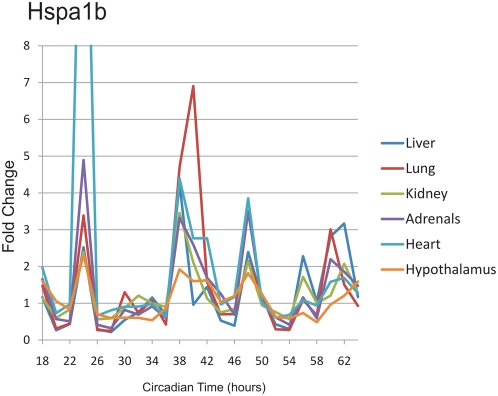
qPCR profiling of Hspa1b reveals 12 h rhythms in multiple tissues.RNA samples from six different tissues were collected at a two-hour resolution between CT18 and CT64. These samples were analyzed using qPCR probes, median normalized, and plotted against CT time. Notably, in every tissue tested, Hspa1b shows four peaks of expression during the 48 h time course; in every case, the phase of these rhythms is invariant between tissues.